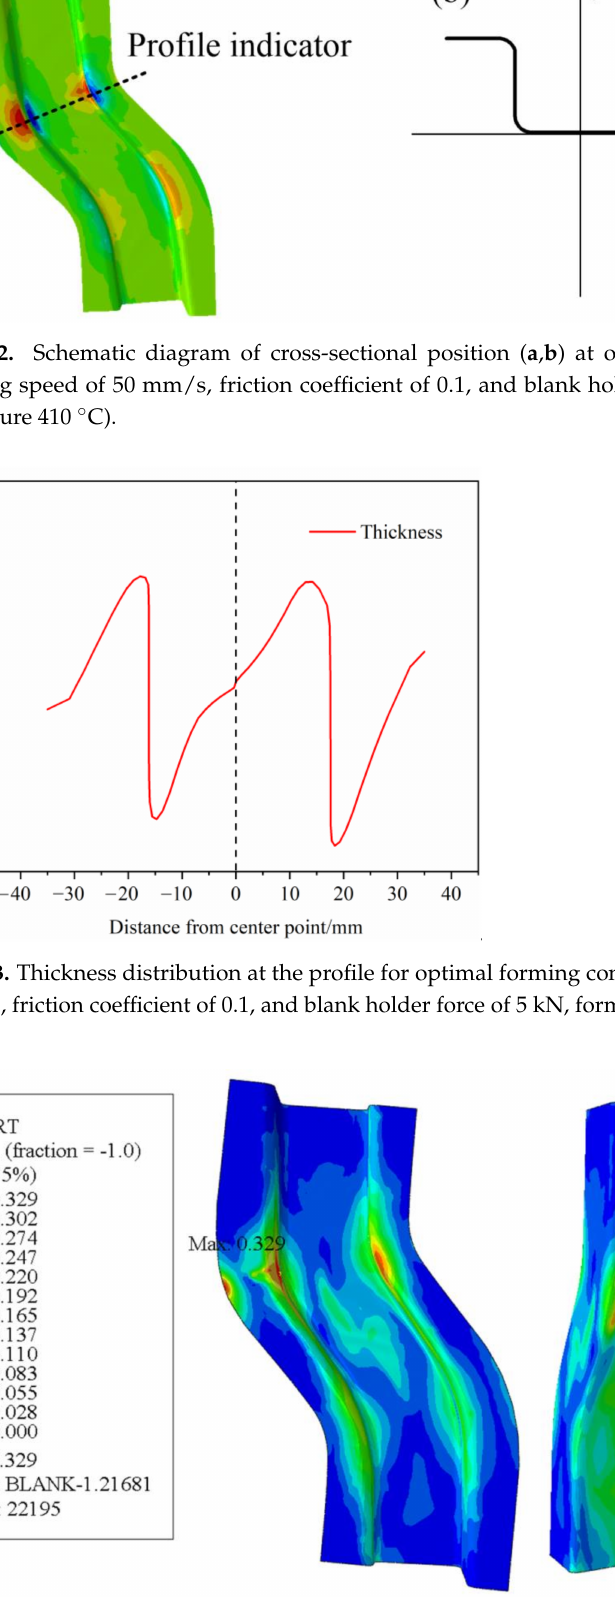
Figure 24. S-rail FLD damage cloud map at optimal forming conditions (stamping speed of 50 mm/s, friction coefficient of 0.1, and blank holder force of 5 kN, forming temperature 410 ◦